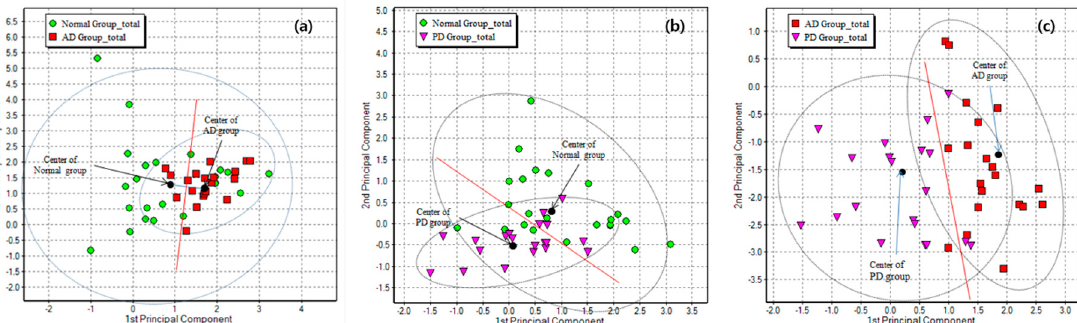
Figure 6. Distribution of clusters by Principle component analysis (PCA) pattern analysis for exhaled breath samples from patients with Alzheimer’s disease (AD), Parkinson’s disease (PD), and from healthy individuals as a control group using system A. ( a ) AD patients and healthy individuals; ( b ) PD patients and healthy indivisulas; ( c ) AD patients and PD patients.